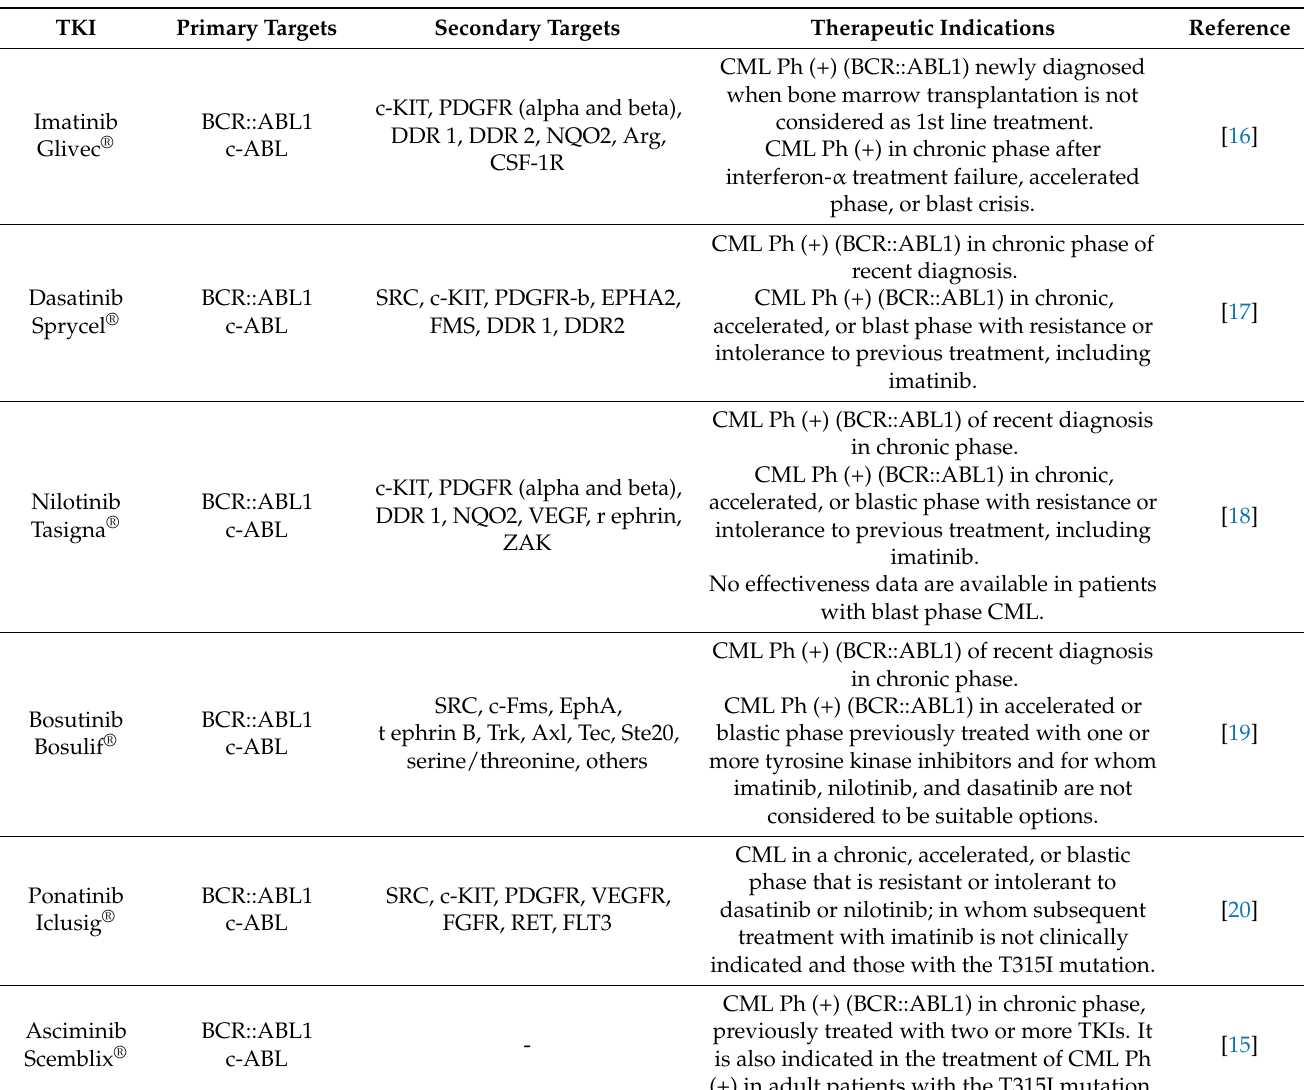
Table 1. Comparison of different tyrosine kinase inhibitors